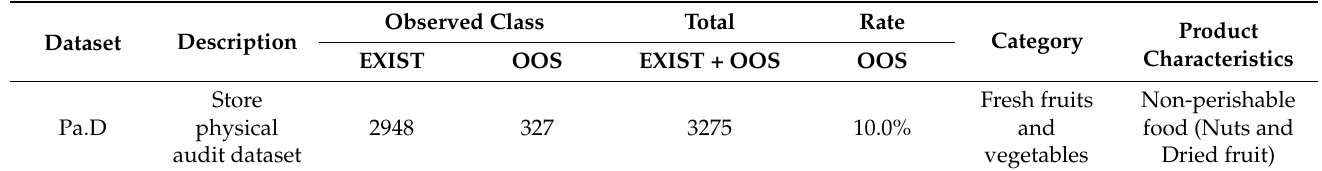
Figure 4. Case Study Modeling Proposal. ( a ) Simplified layout of a retail store [2]; ( b ) Complete model scope addressed in this work, starting from the Manufacturer and ending at the Supermarket store. Table 3. Physical store